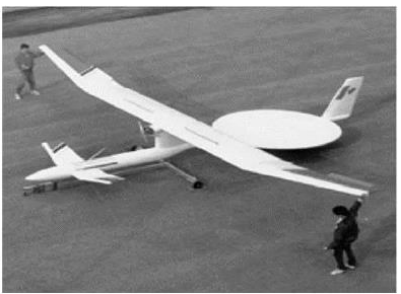
Figure 10. UAV designed by SHARP program. Reproduced with permission from Ref. [39]; published by IEEE, 1988.